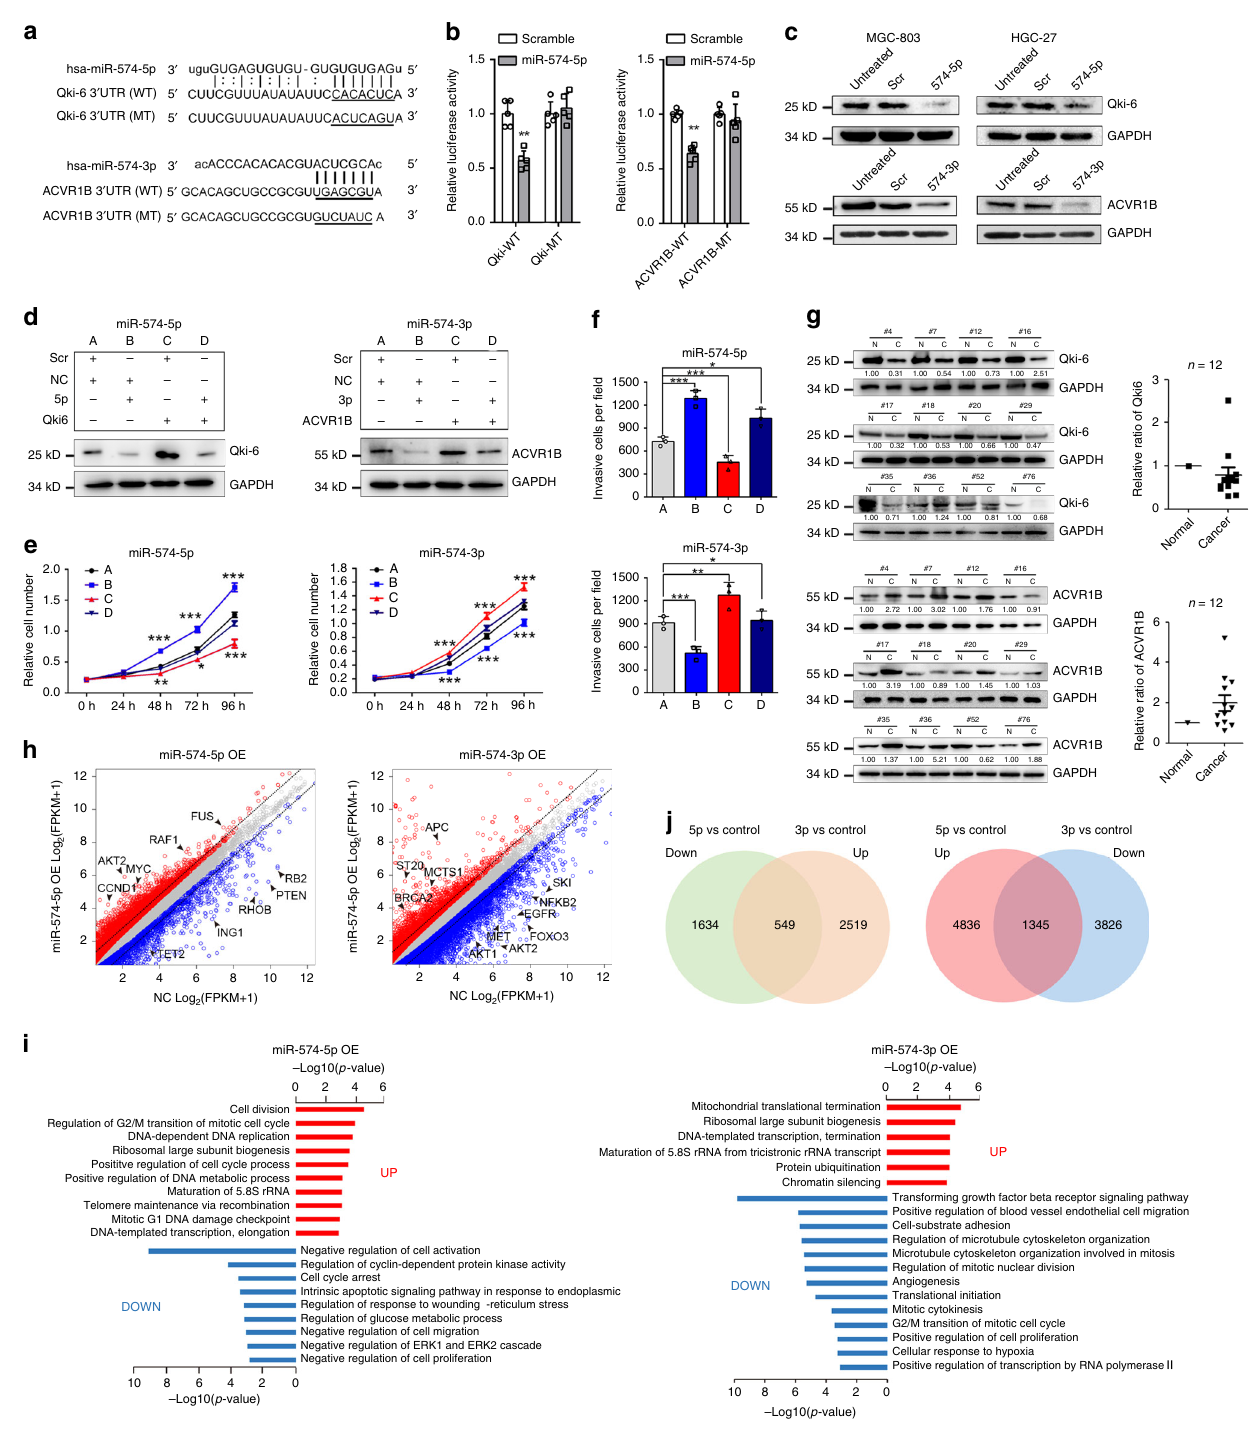
Fig. 3 miR-574-5p/3p targeted endogenous QKI6 and ACVR1B, respectively. a Schematic representation of QKI6 and ACVR1B 3 ′ UTRs showing putative miR-574-5p/-3p binding site. b Relative luciferase activity of wild type (WT) QKI6 or ACVR1B 3 ′ UTRs constructs and miRNA binding site mutated constructs (MT) in 293T cells treated with scramble or miR-574-5p/-3p mimics. Three technical replicates from a single experiment representative of three independent experiments. c The protein level of QKI6 and ACVR1B in GC cells treated with scramble or miR-574-5p/-3p mimics. d The protein level of QKI6 and ACVR1B in MGC-803 cells co-transfected with microRNA mimics and QKI6 or ACVR1B overexpression constructs. e Cell proliferation analysis of MGC-803 cells in different groups shown in panel ( d ). Three technical replicates from a single experiment representative of two independent experiments. f The relative invasive cells of MGC-803 cells in different groups shown in panel ( d ). Three technical replicates from a single experiment representative of two independent experiments. g The protein level of QKI6 and ACVR1B in 12 GC tissues compared with the adjacent normal tissues. h Differential expressed genes in MGC-803 cells treated with miR-574-5p/-3p mimics. i GO and KEGG pathway analysis of differential expressed genes induced by miR-574-5p/-3p overexpression. j Comparison of differential expressed genes induced by miR-574-5p and miR-574-3p. Data are shown as means ± s.d. * p < 0.05, ** p < 0.01, *** p < 0.001, Student ’ s t